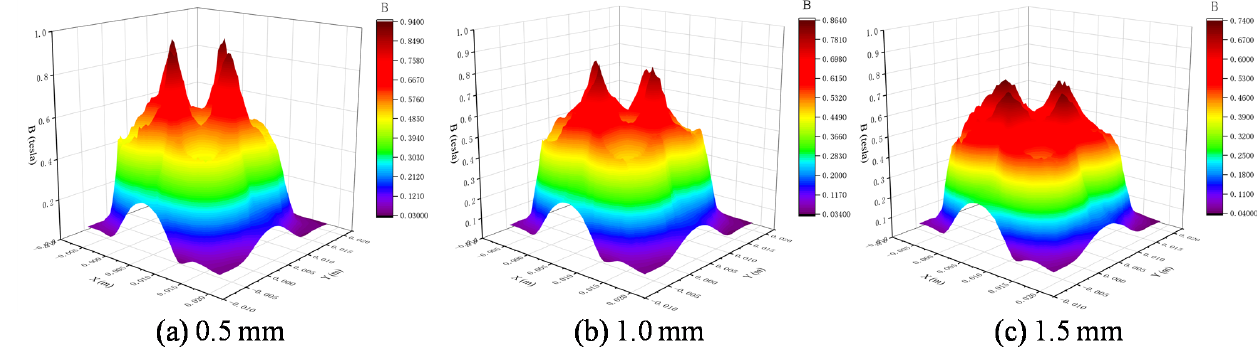
Figure 2. Cloud chart of scalar magnetic induction intensity with different magnetic pole spacing under natural